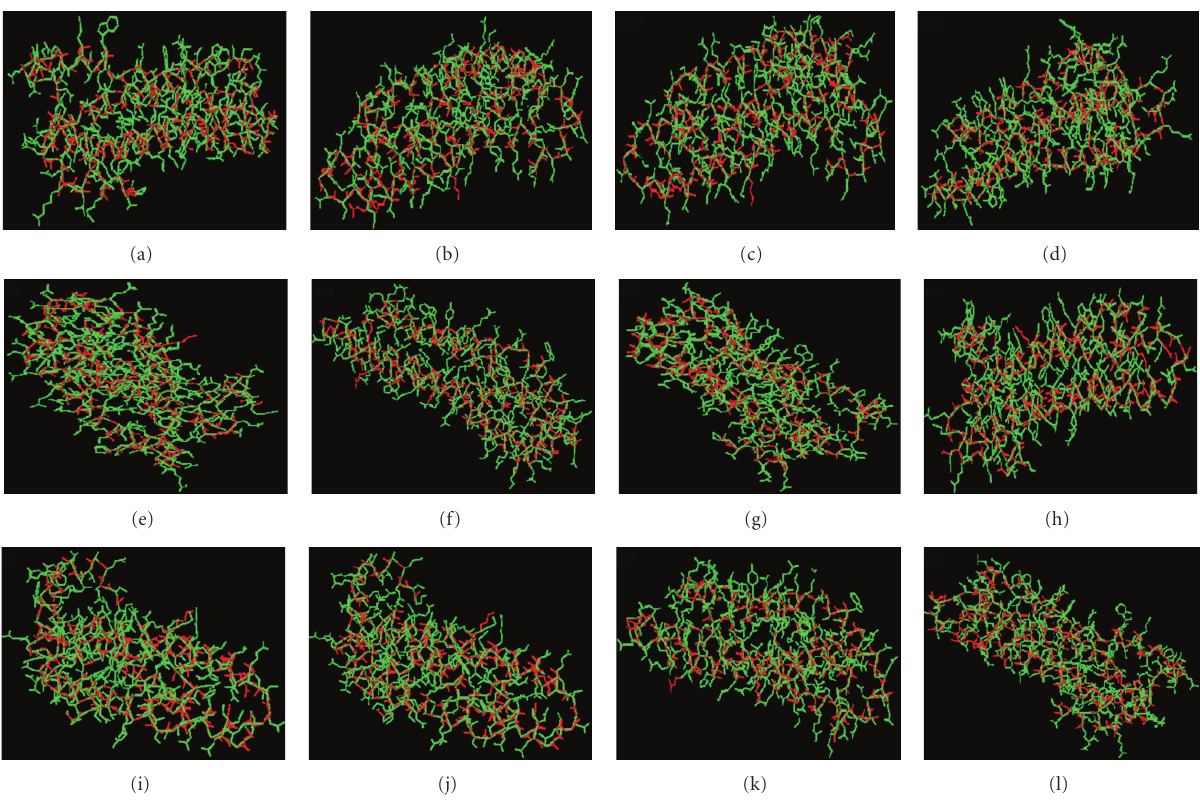
Figure 1: Superimposed homology modeled structure (green) with (a) mutant (E139V), (b) mutant (E150G), (c) mutant (E189K), (d) mu- tant (K164Q), (e) mutant (P102Q), (f) mutant (P102R), (g) mutant (P102T), (h) mutant (R50C), (i) mutant (R132S), (j) mutant (R152Q),